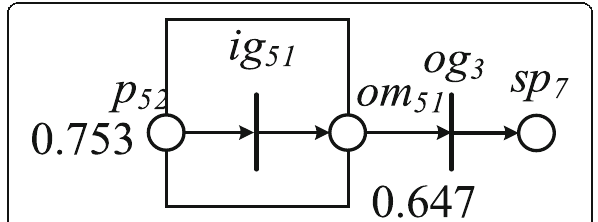
Fig. 12 COP model with an attack gate threshold of